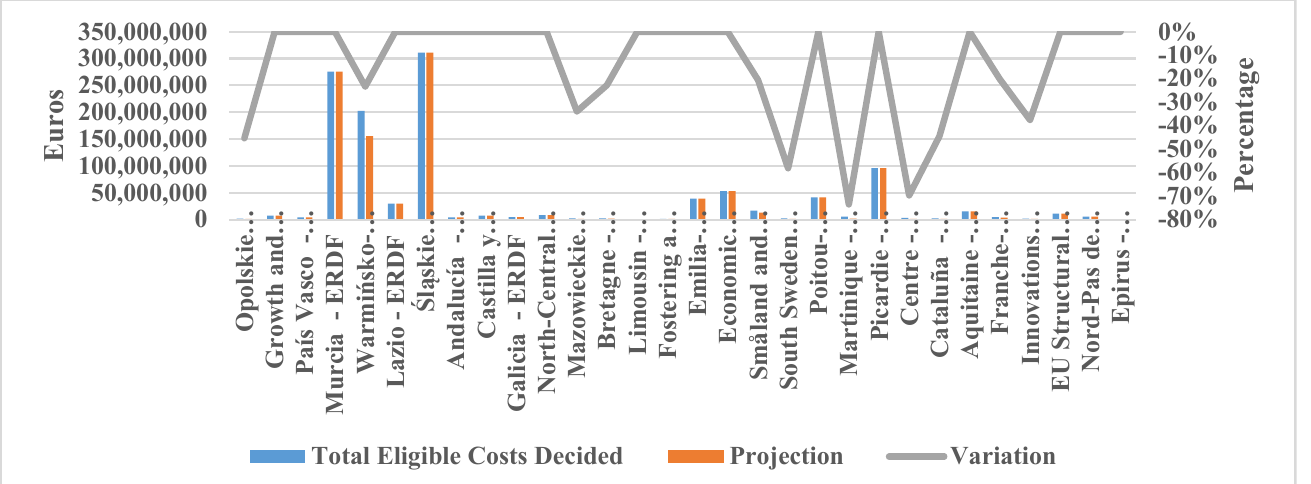
Figure 12. Potential input improvement for every inefficient OP.